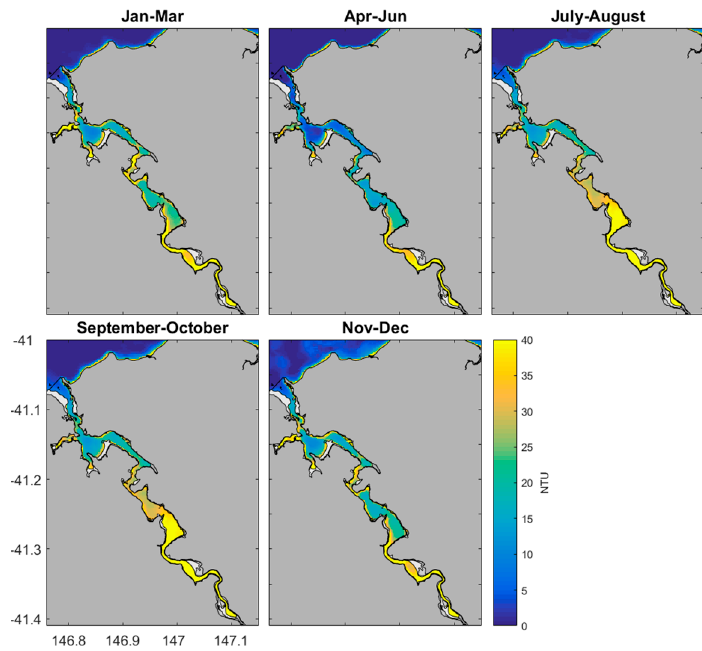
Figure 5. Seasonal satellite-derived climatology (only with data for highest coefficients of determination).